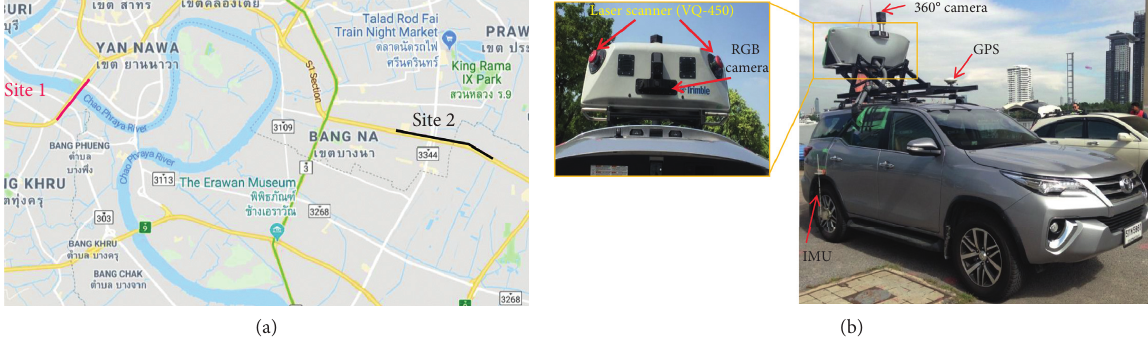
Figure 2: Two test sites. (a) Study area and (b) overview of the GT-4 MLS